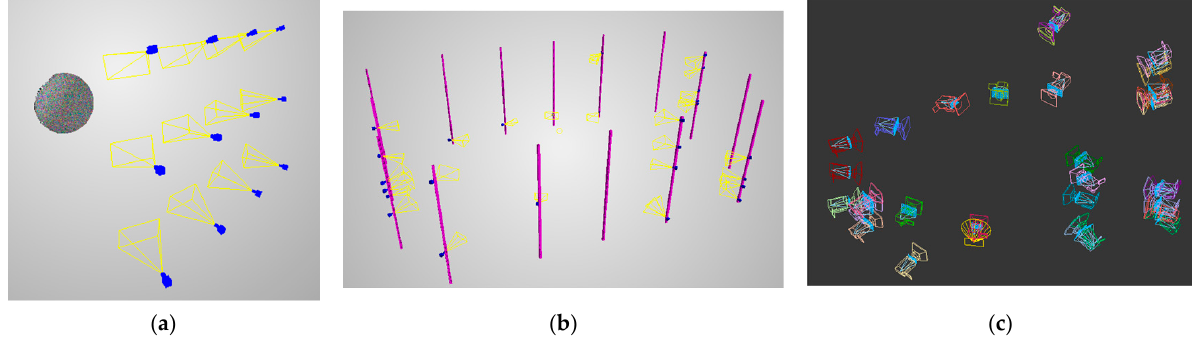
Figure 4. Example of a ( a ) 12-camera setup with the reconstructed sphere; ( b ) 360-degree scene with camera distribution view with columns; ( c ) print screen from 3dsmax of the same 360-degree scene.